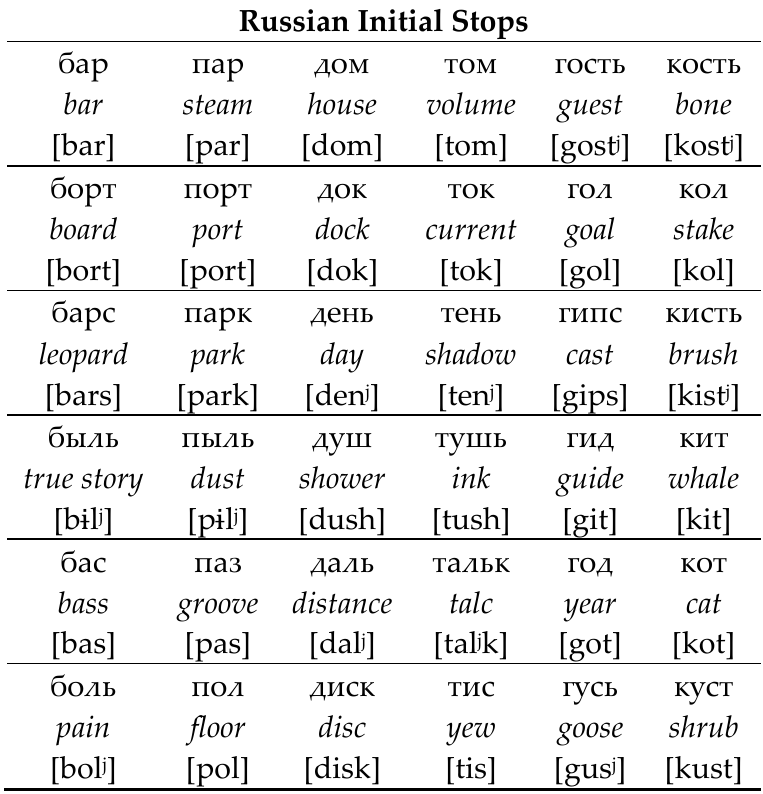
Table A3. Russian minimal pairs with voiced and voiceless plosives in word-initial position.